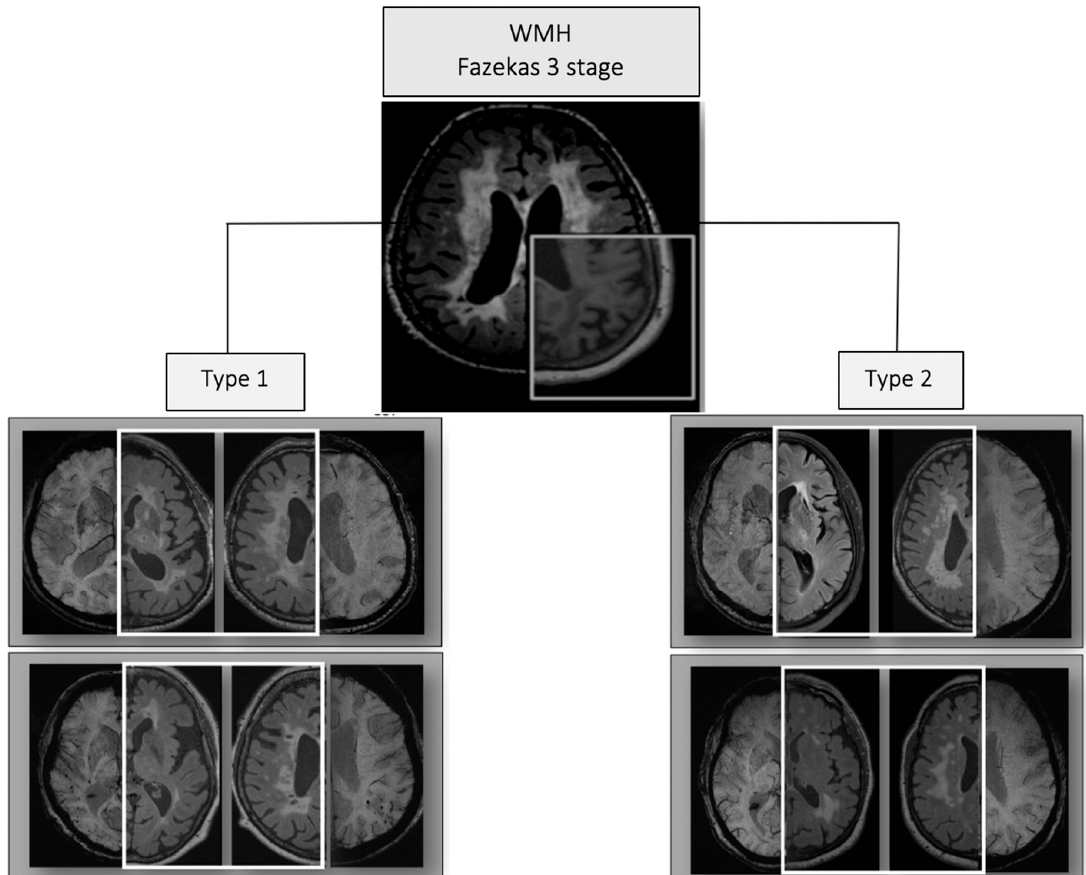
Figure 2. Characteristic changes observed in MRI types 1 and 2 of Fazekas stage 3 cerebral small vessel disease (cSVD) on FLAIR (highlighted with a white square) and axial susceptibility weighted imaging sequence (SWI) MRI slices.